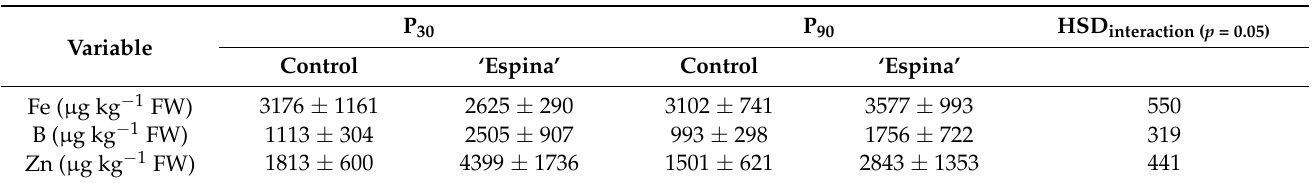
Table 5. Iron, boron and zinc concentrations in eggplants (mean ± standard deviation) as affected by ‘phosphorus level × grafting’ interaction.